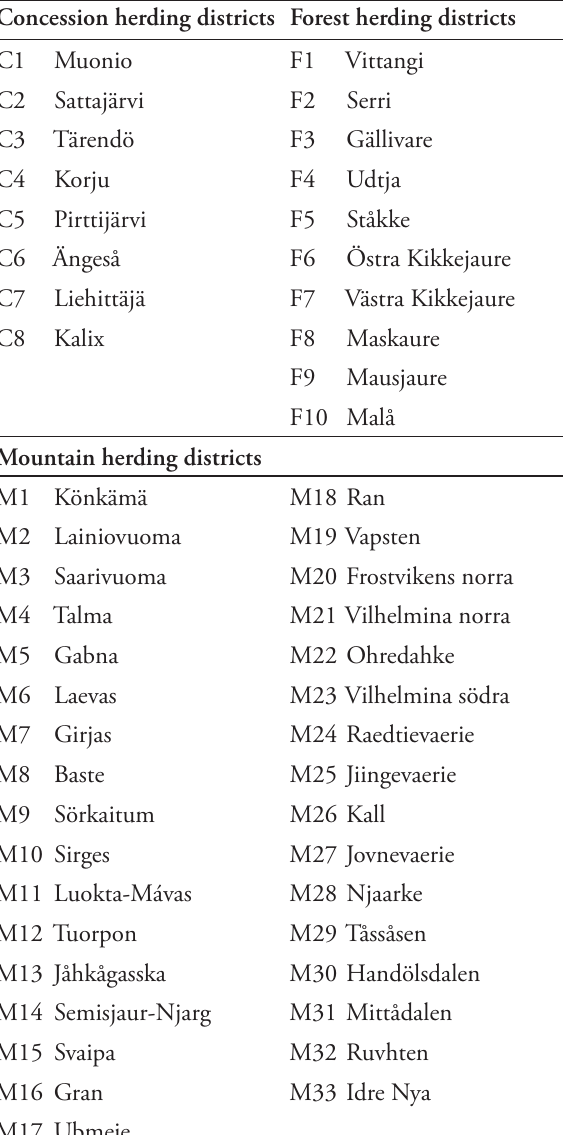
Fig. 5b for the geographical distribution of the suggested grouping of herding